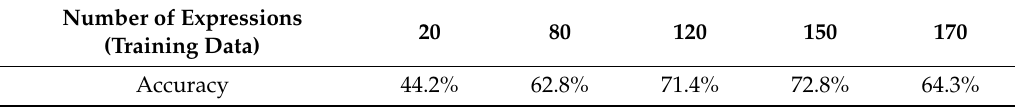
Table 4. The e ff ect of the number of expressions on the accuracy of